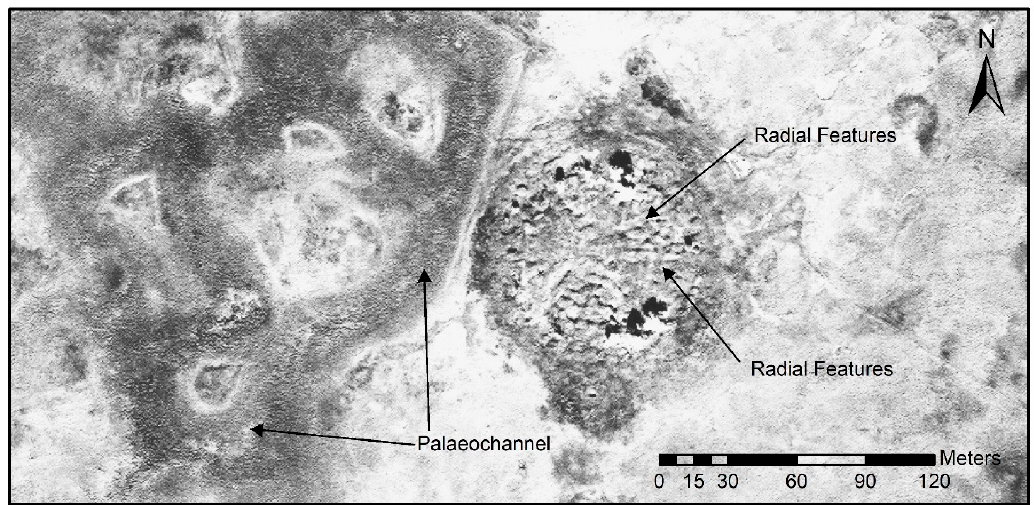
Figure 2. High-resolution WorldView-2 data (panchromatic band with 0.46-m resolution at nadir) of the site clearly shows later paleochannels which impacted the western border of the burial mound. On the burial mound, vague radial features can be identified.